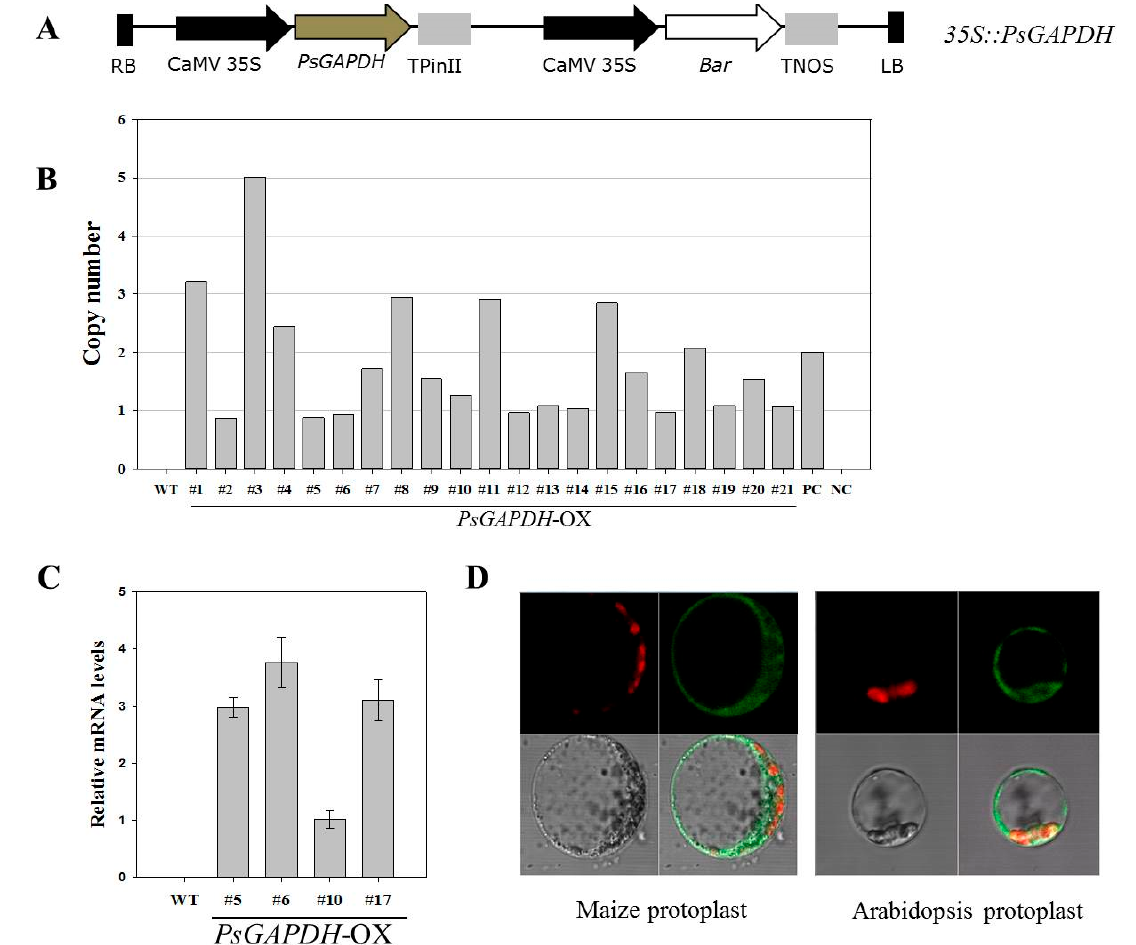
Figure 1. Generation of transgenic rice plants overexpressing PsGAPDH . ( A ) Schematic diagram of a plant expression vector pPZP- PsGAPDH used for overexpressing PsGAPDH in transgenic rice. ( B ) TaqMan copy number analysis of PsGAPDH transgenic plants for transgene copy determination. ( C ) Expression levels of PsGAPDH in transgenic plants by quantitative real time-PCR. Three transgenic lines (#5, #6, and #17) displayed high PsGAPDH expression compared to #10 plant. ( D ) Subcellular localization of PsGAPDH. Fluorescence signals in maize and Arabidopsis protoplasts were visualized using a confocal laser-scanning microscope. #, number; RB,T-DNA right border; LB, T-DNA left border; WT, wild type; PC, positive control; NC, negative control.